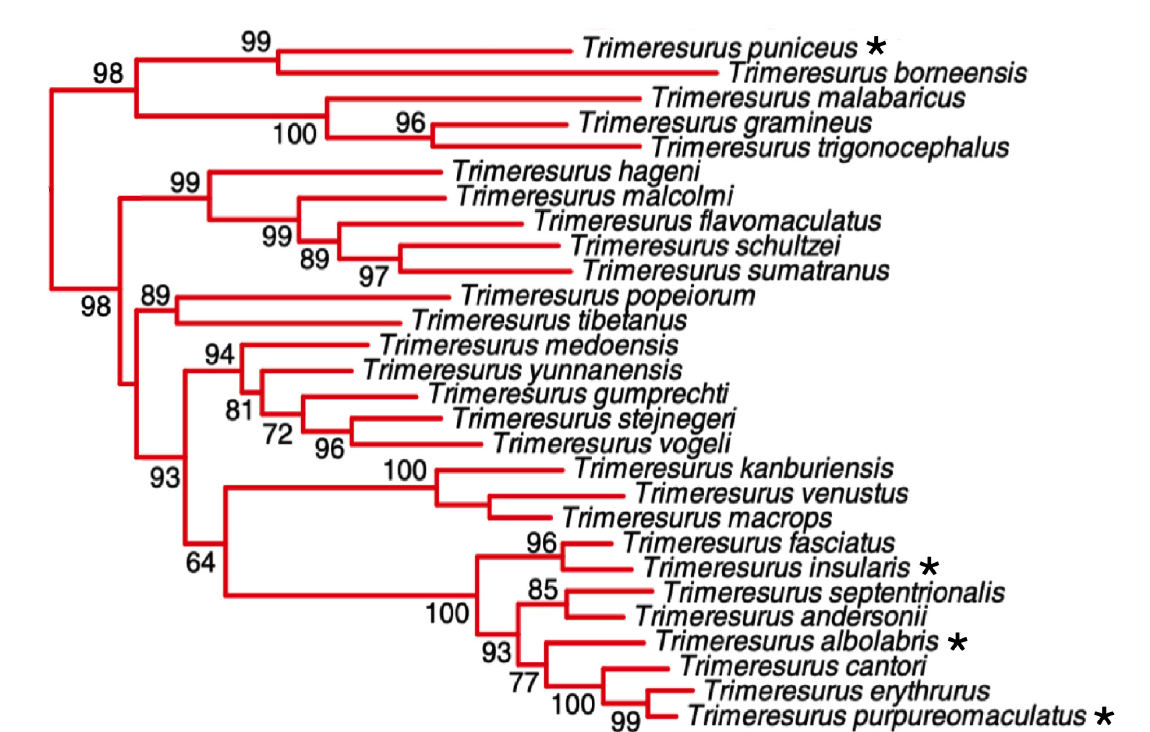
Figure 1. Phylogeny of the Asian pit viper ( Trimeresurus ) complex, adapted from Pyron et al. [6]. Black asterisks mark the species sampled in the present study.